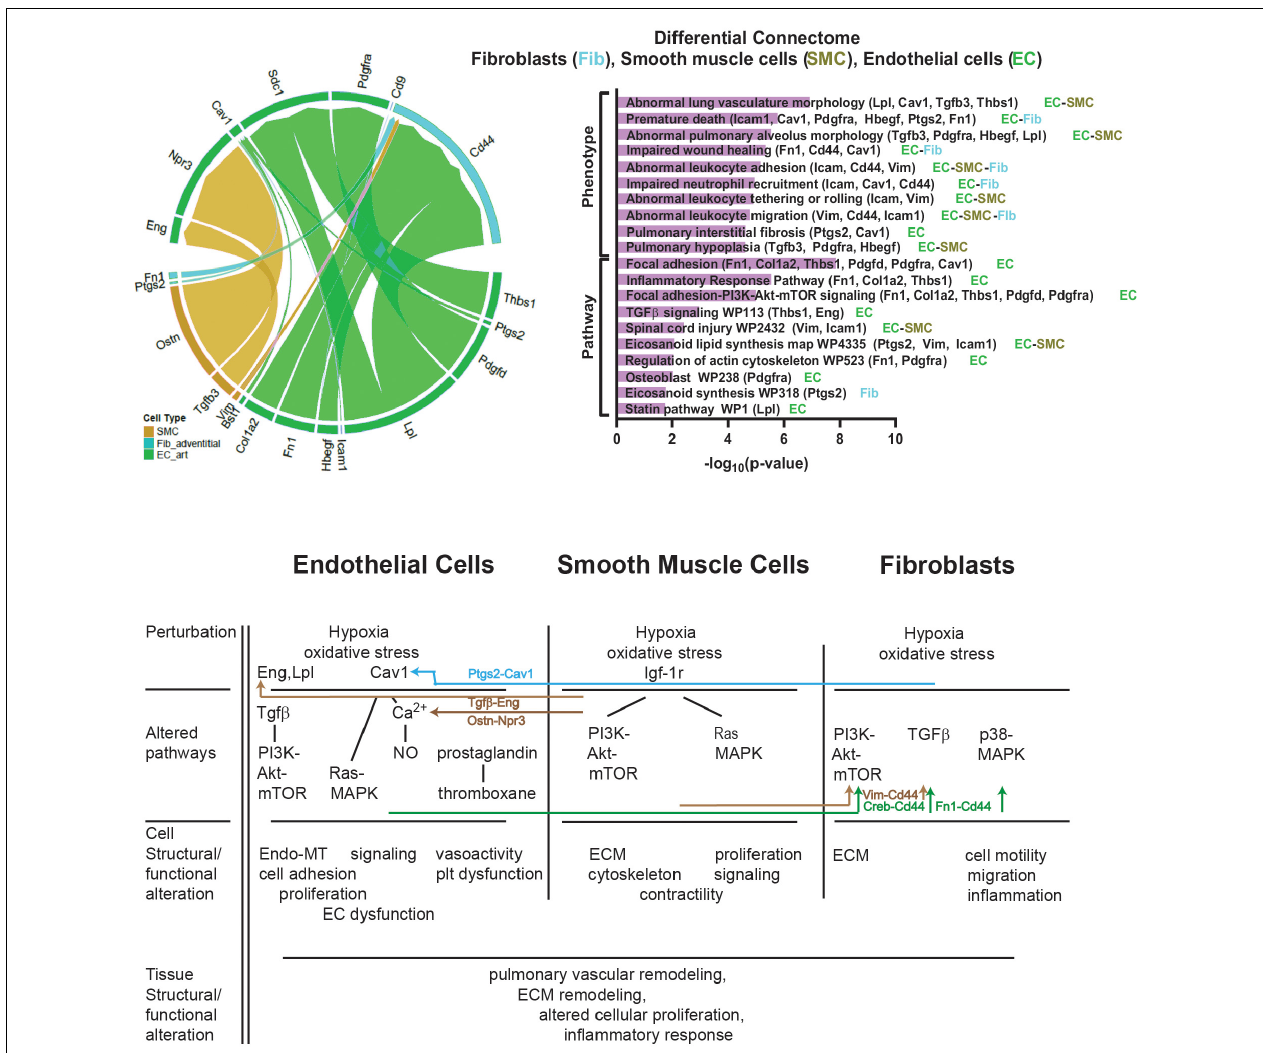
FIGURE 6 | Hypoxia-normoxia differential connectome of mouse pulmonary artery resident cells. (Left) Differential connectome mapping comparing hypoxic and normoxic communication based on scRNAseq data to identify differences between hypoxic and normoxic cell-cell signaling. Differential connectomic analysis identifies and visualizes the major perturbed cell–cell communication pathways between single cell data from similar cell types under two different conditions, in this case hypoxia versus normoxia, using ligand-receptor connectomic analysis (Raredon et al., 2019). Connecomtic analysis is an algorithm to visualize intercellular signaling using ligand-receptor mapping. It filters single-cell data to identify the distribution of ligand and receptor z-scores and percentage expression to identify cell-type specific communication patterns (edges) with increased statistical confidence. The thickness of the edges is proportional to the ligand and receptor z-scores. The bottom half of the circle identifies the ligand gene and “sender” cell-type, the top half of the circle identifies the receptor gene and “receiver” cell-type. (Right) Enriched terms analysis of phenotype (using MGI Mammalian Phenotype Level 4 2019 database) and signaling pathways (using WikiPathways 2019 Mouse database) based on genes identified through differential connectome analysis. The bar chart shows the top enriched terms in the chosen library based on their p -value (plotted as − log 10 p -value). Genes associated with the identified phenotype or pathway are listed along with the cell-type in which these genes were found to be expressed. The differential connectome cell-cell signaling genes identified accurately represent observed phenomena and pathways associated with phenomena observed in our experiments including abnormal lung vasculature, fibrosis, alterations of cell cycle, regulation of actin cytoskeleton, TGF-beta signaling, and alterations in focal adhesion. Whether this type of analysis hold predictive abilities requires further investigation. (Bottom) Potential cell–cell interactions between based on the differential connectome demonstrating how differentially expressed genes from one cell type may influence gene expression and cellular pathways in another cell type. ECM = ECM = extracellular matrix. Endo-MT = endothelial-mesenchymal transitioning. EC = endothelial